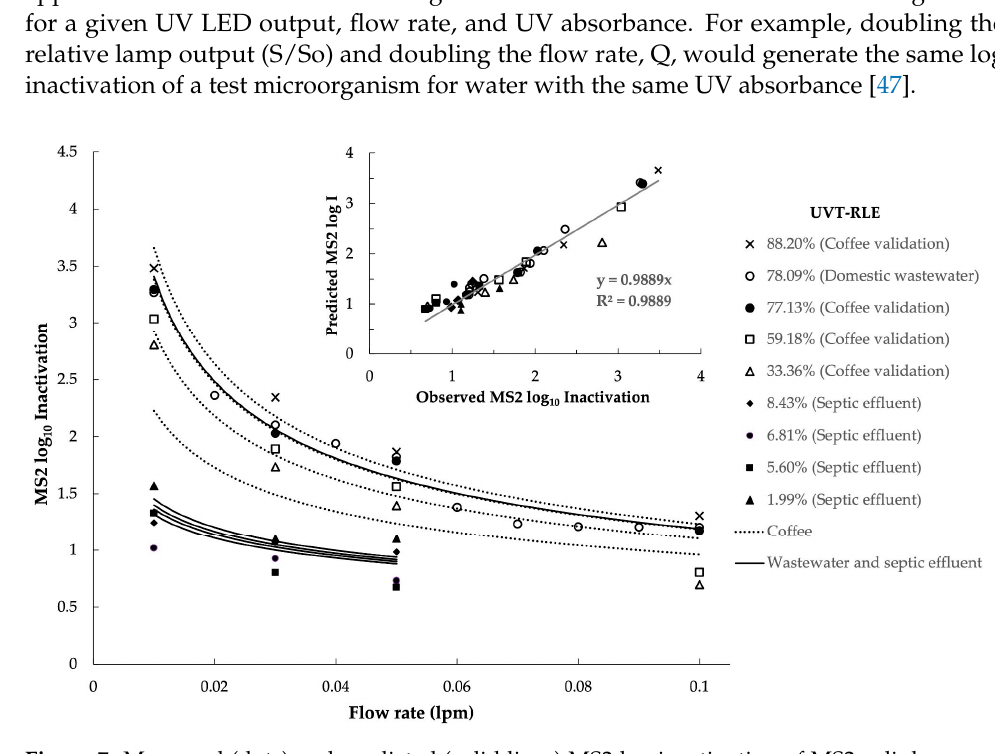
Figure 7. Measured (dots) and predicted (solid lines) MS2 log inactivation of MS2 coliphage as a function of the UV LED system flow rate and UVT-RLE. Values predicted using a combined variable approach Equation (2) as a function of UVA-RLE (presented as UVT-RLE) and flow rate with model coefficients a = − 0.38058, b = 0.0, c = 0.48857, d = − 0.30841, and e = 0.09897. Coefficients a, c, d, and e were statistically significant ( p < 0.05), whereas b was not. Inset: Predicted MS2 log inactivation versus observed MS2 log inactivation for the UV LED reactor (276 nm) for wastewater, septic tank effluent, and coffee validation. RLE = relative lamp emission; UVT = ultraviolet transmittance.